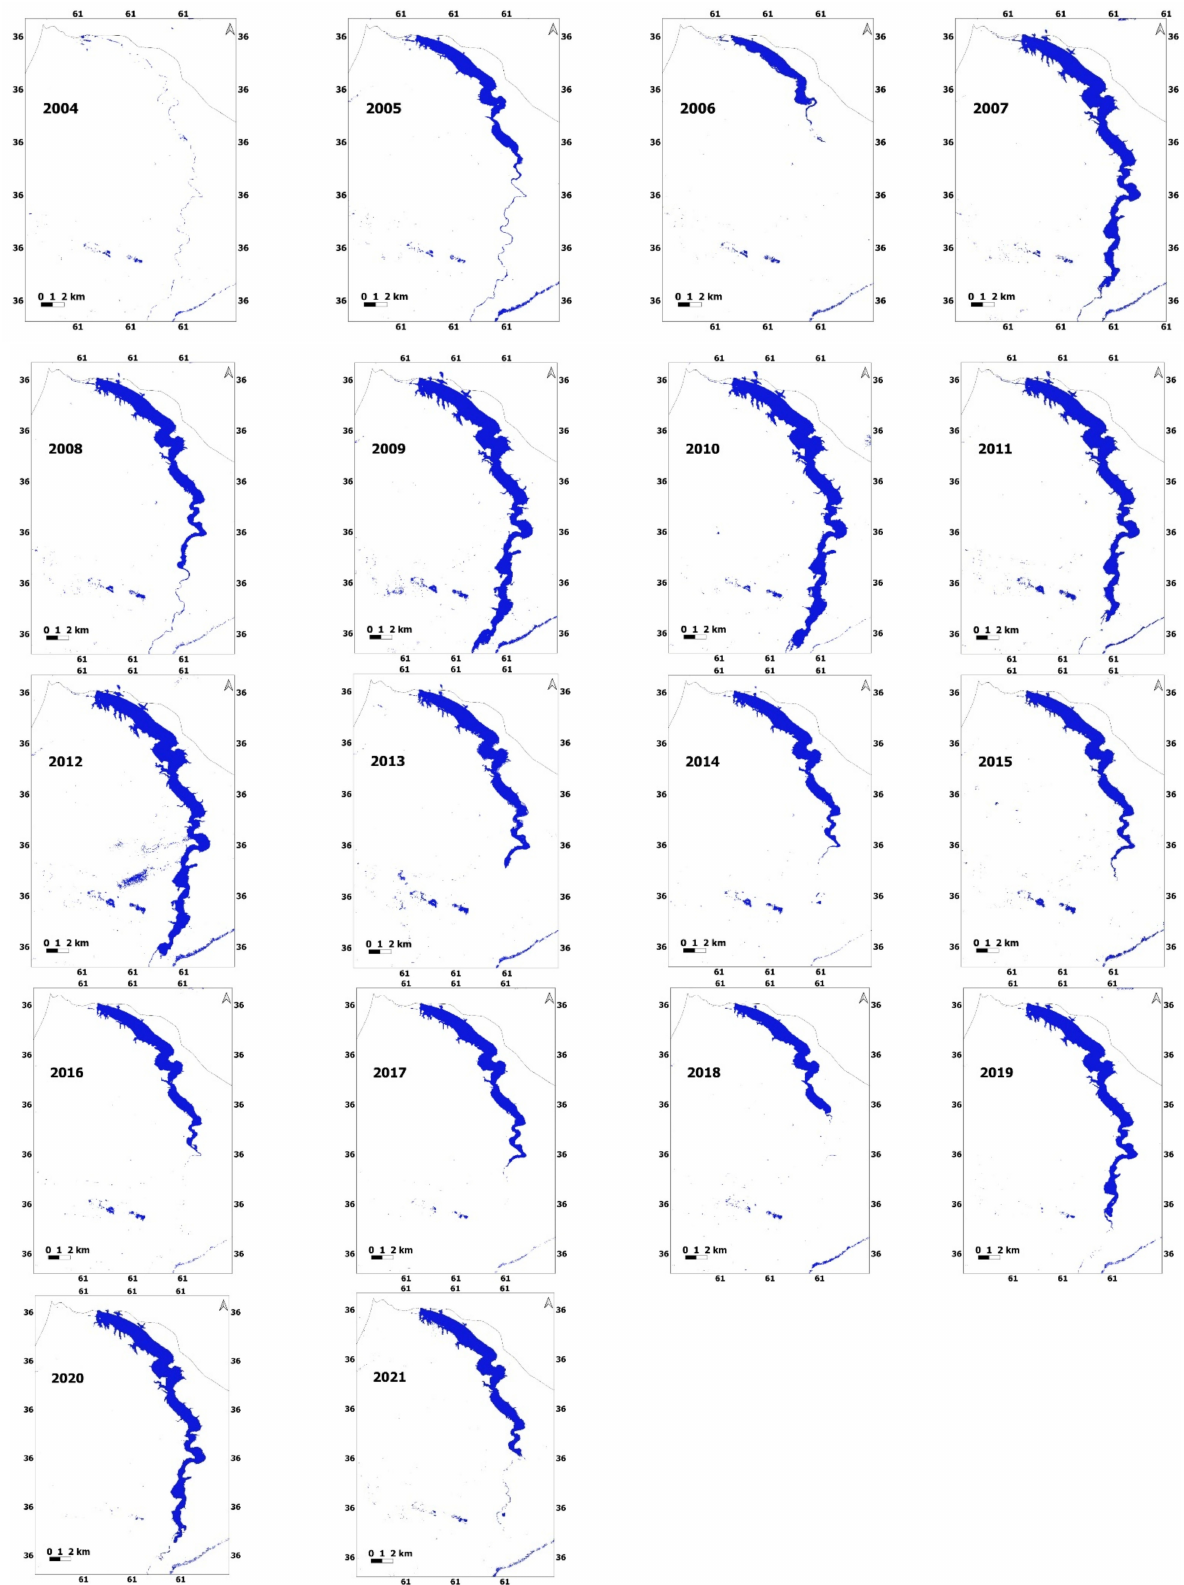
Figure 4. Area of Doosti Dam’s reservoir from 2004 to 2021 using